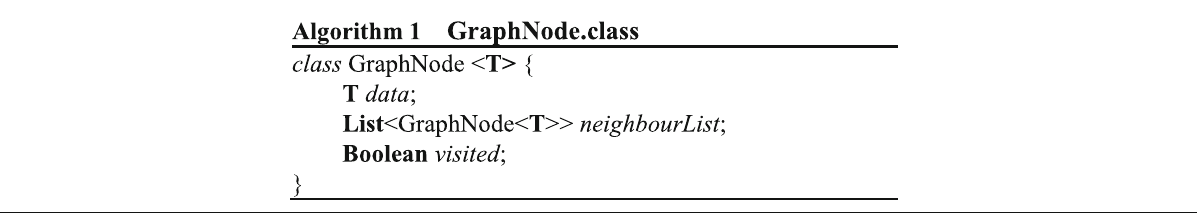
Table 2 GraphNode data structure